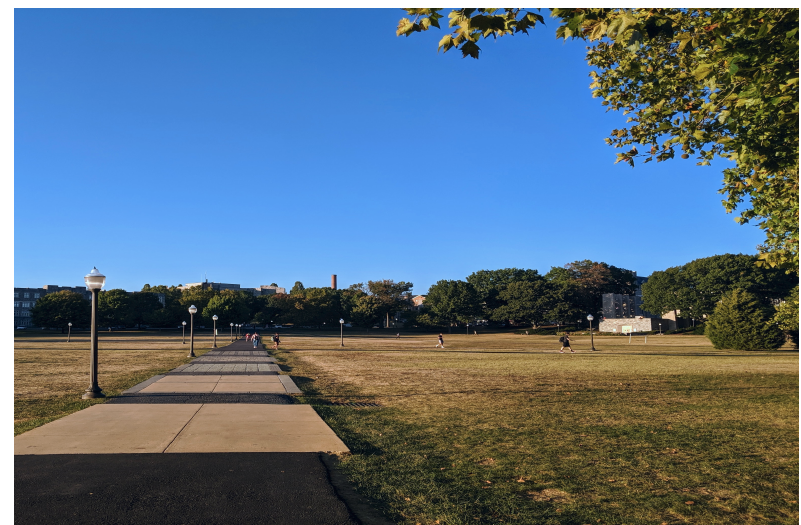
Figure 14. The Virginia Tech drillfield is a typically popular spot for students to gather; this image serves as an example of a potentially ideal spot to record live data for